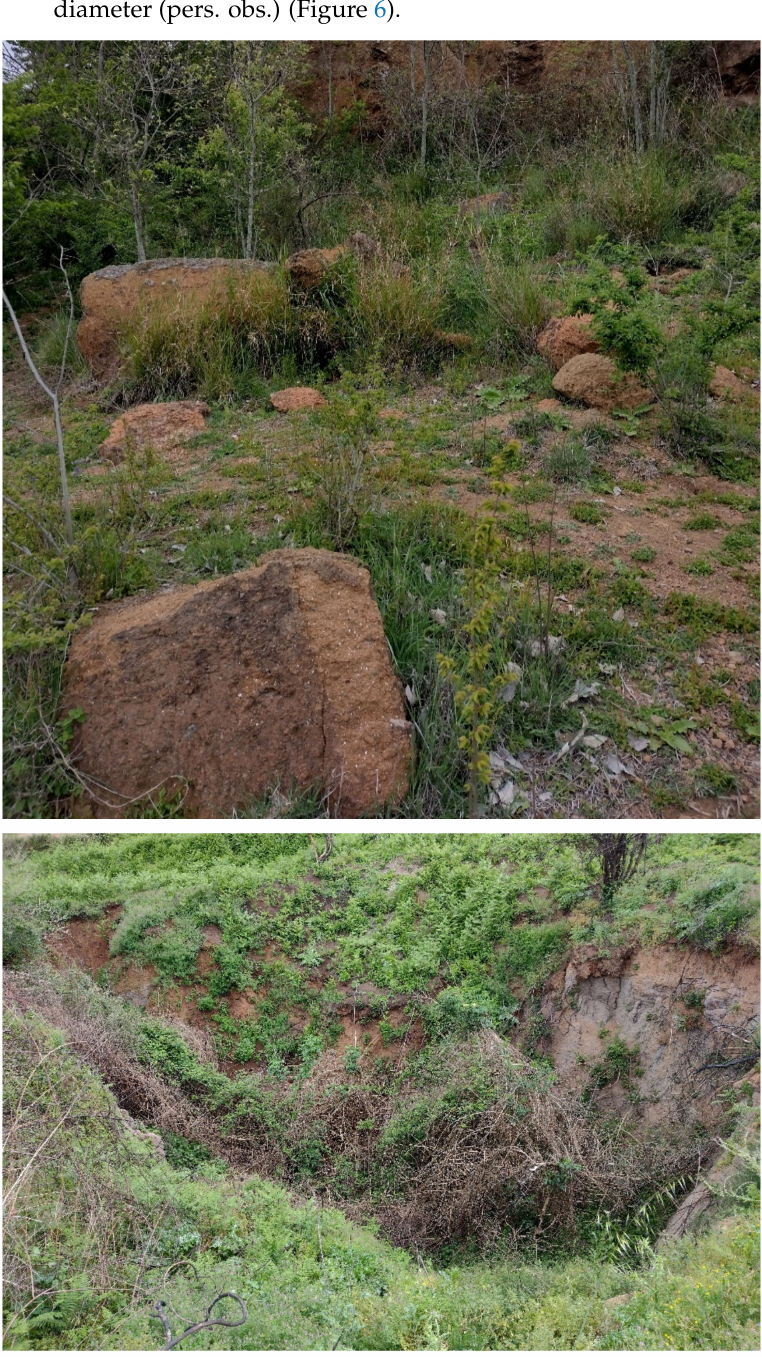
Figure 6. Gravitational landforms: fall on the east side of Caffarella valley (top photo); sinkhole, diameter about 12 m, depth about 5 m (bottom